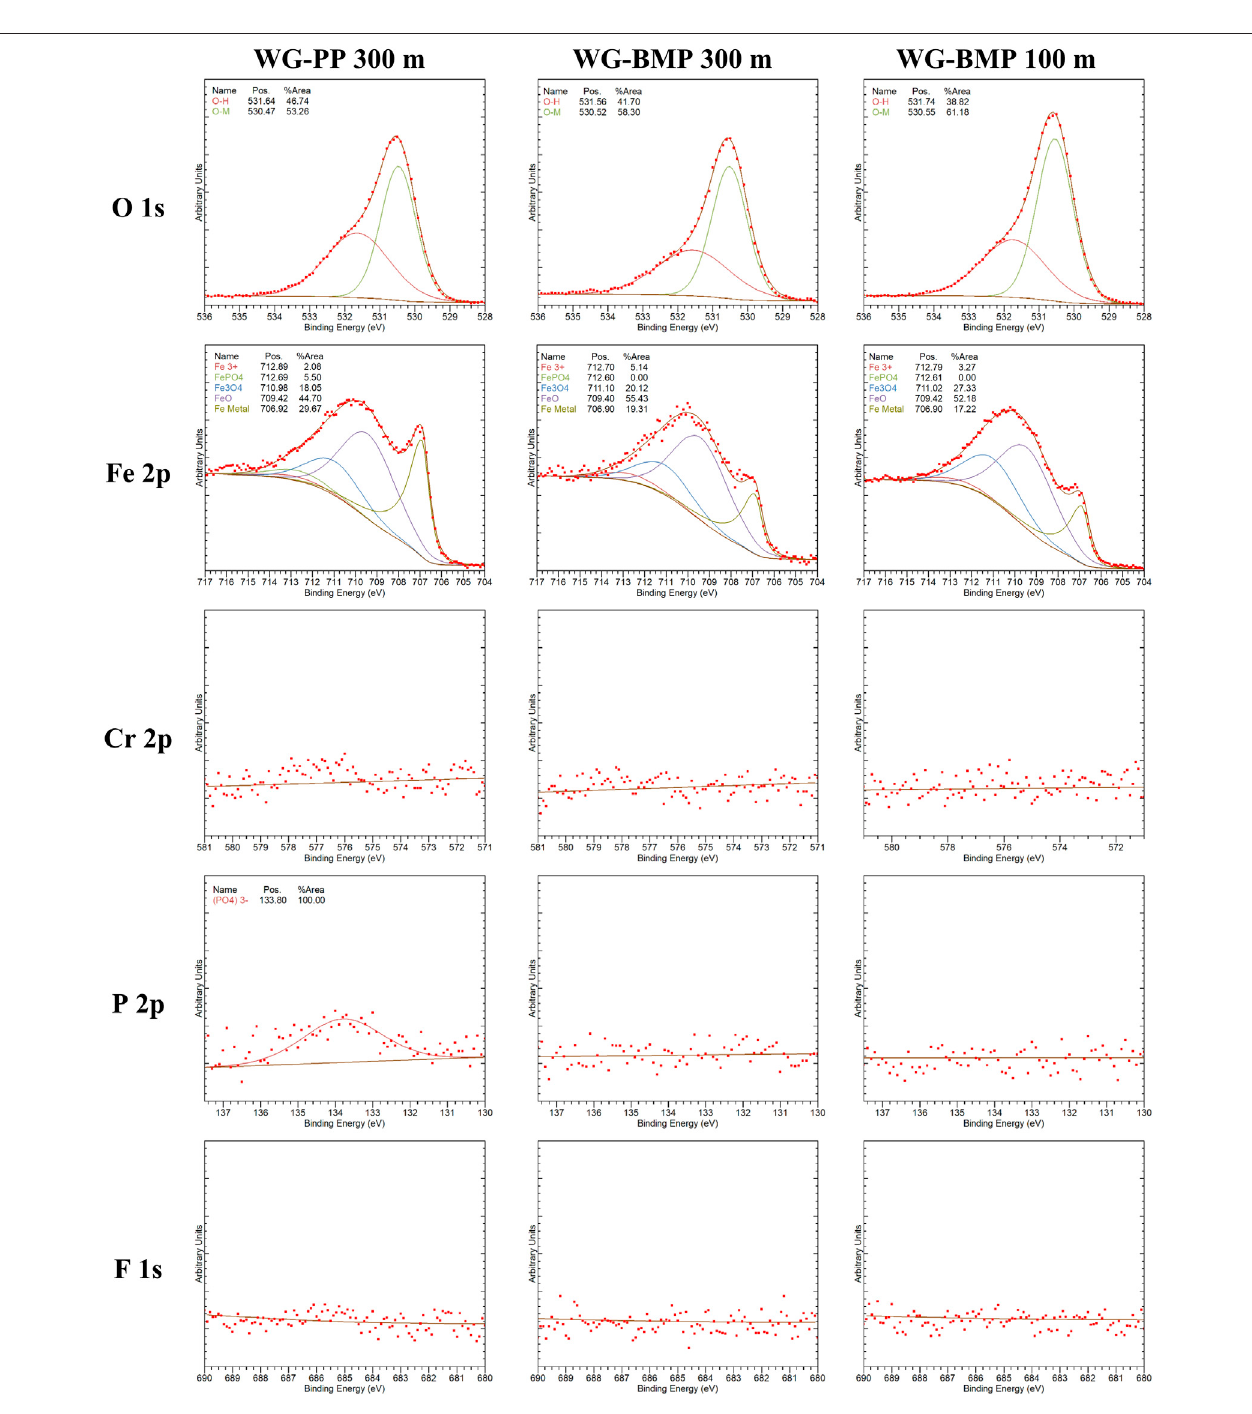
FIGURE 6 | XPS spectra for the wear surface lubricated by WG-PP 300 m, WG-BMP 300 m, and WG-BMP100 m after 300 s Argon sputtering.